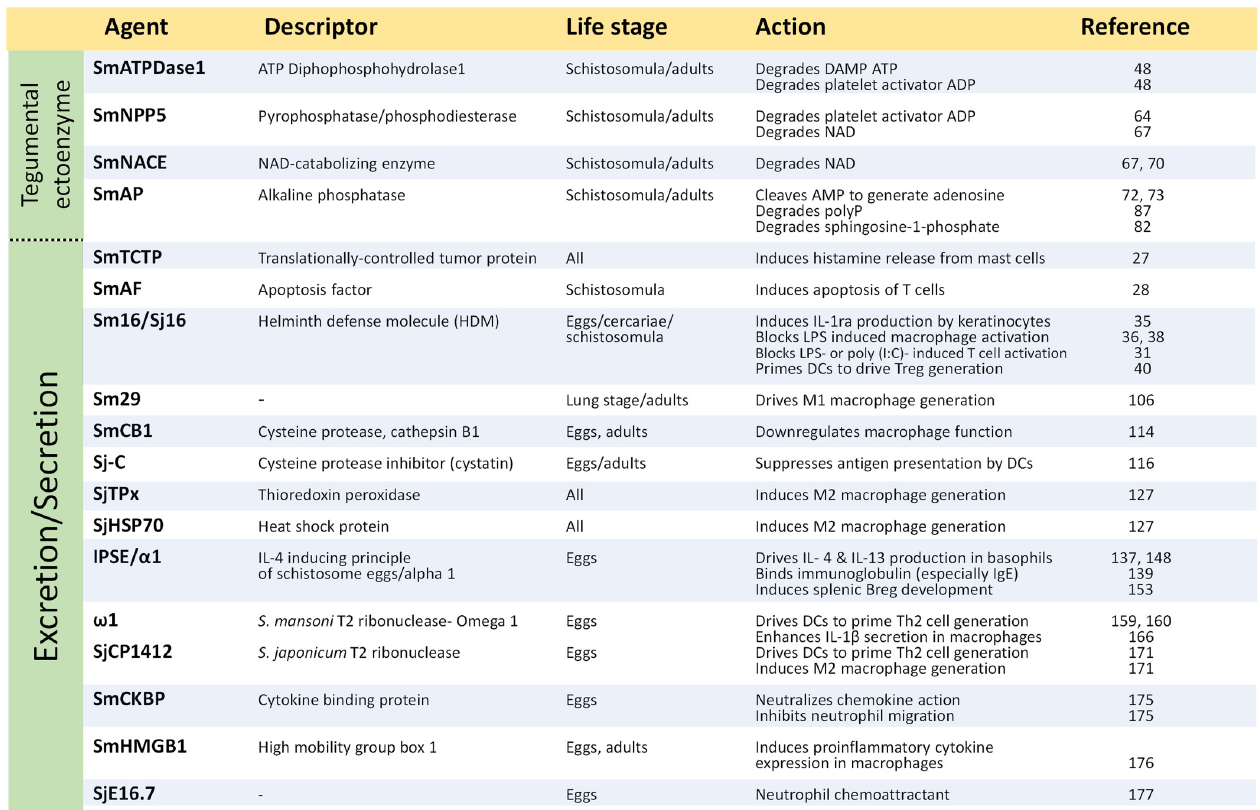
Fig 4. List of immunomodulatory schistosome proteins and their major effects. ADP, adenosine diphosphate; AMP, adenosine monophosphate; ATP, adenosine triphosphate; Breg, regulatory B cell; DC, dendritic cell; HDM, helminth defense molecule; IL-1ra, IL-1 receptor antagonist a; LPS, lipopolysaccharide; NAD, nicotinamide adenine dinucleotide; polyP, polyphosphate; SmAF, S . mansoni apoptosis factor; SmTCTP, S . mansoni translationally controlled tumor protein; Treg, regulatory T